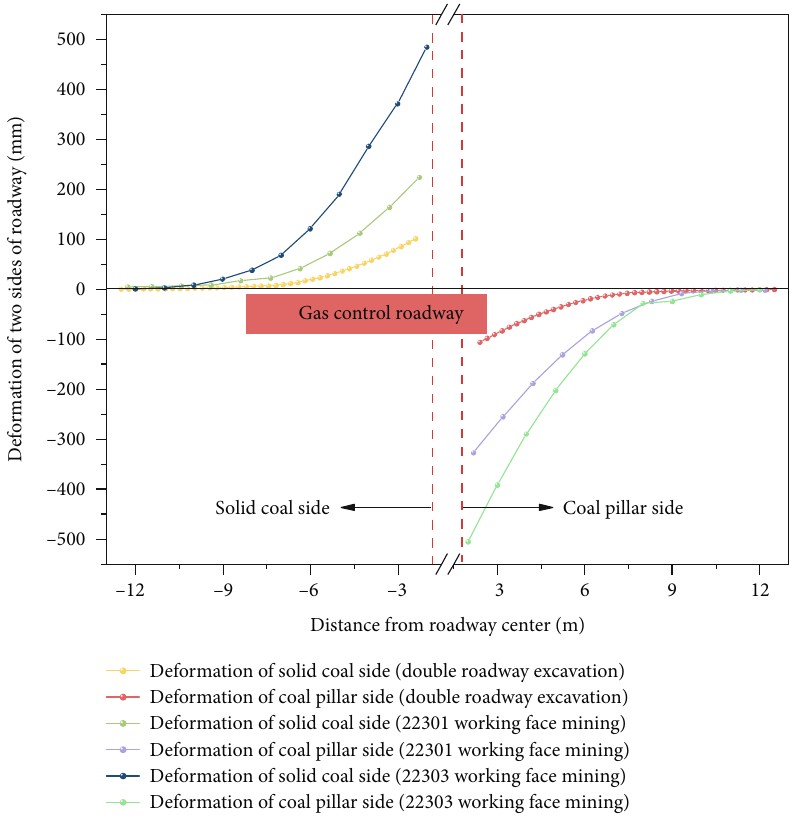
Figure 8: Deformation of two sides of coal roadway with composite roof under multiple dynamic pressure